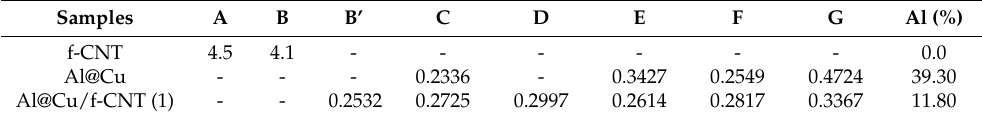
Table 1. FWHM values and percentage of Al in f-CNT, Al@Cu and Al@Cu/f-CNT (1) samples.